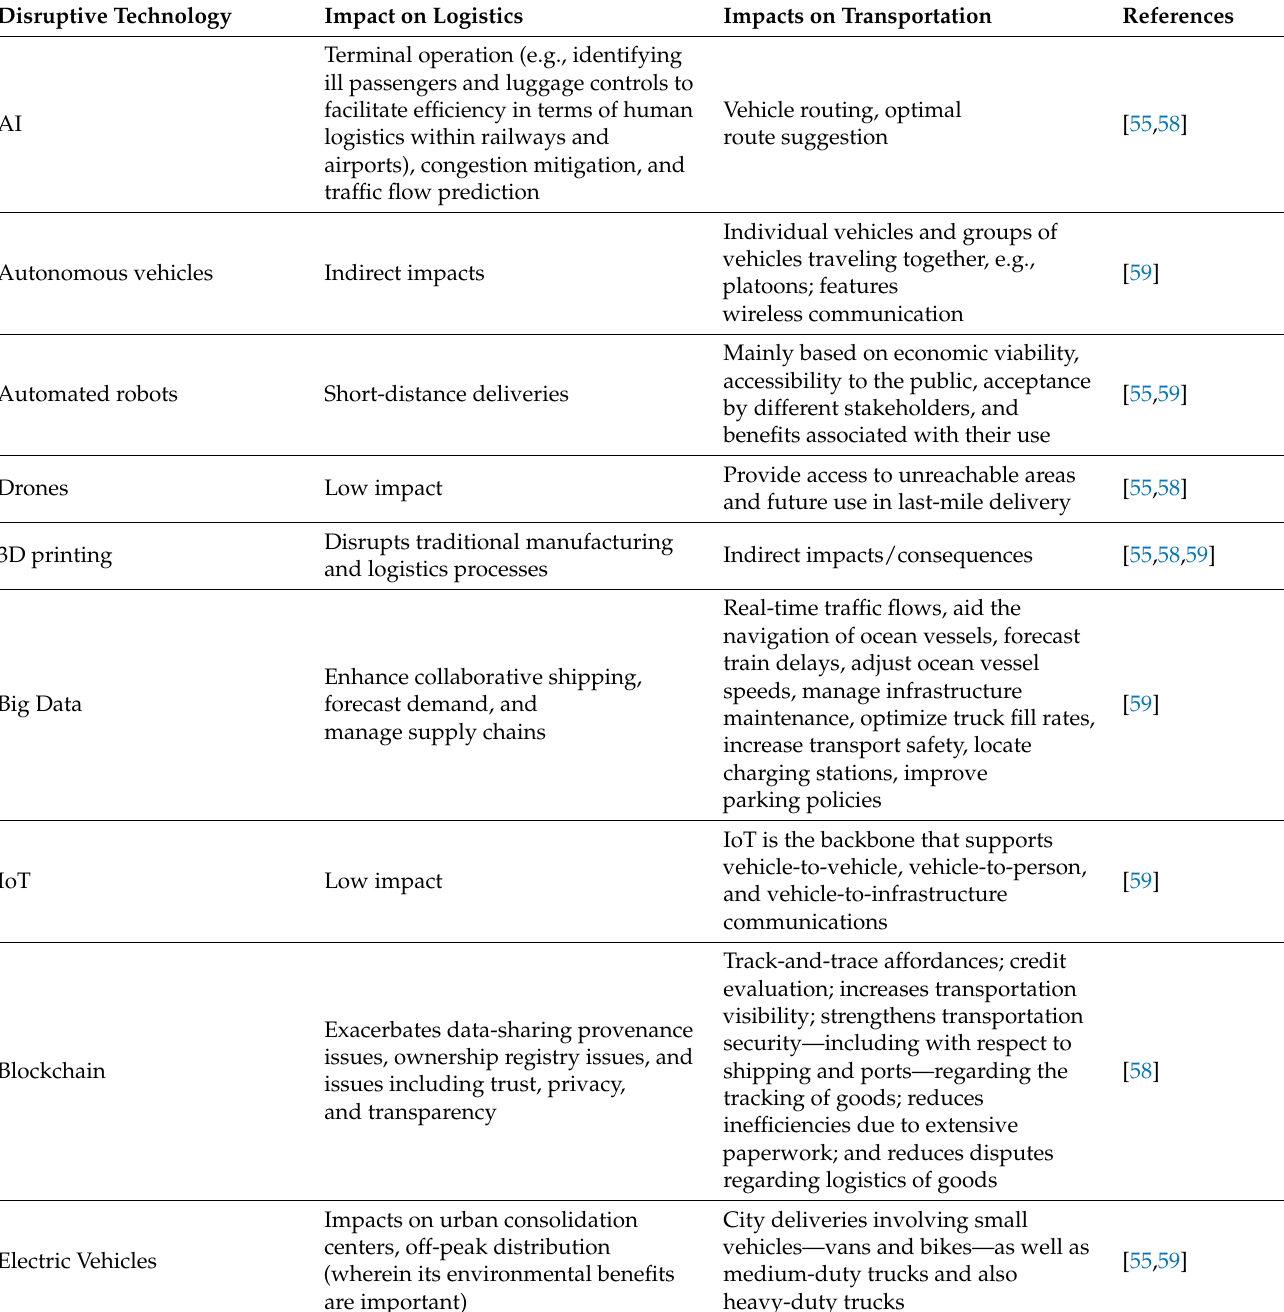
Table 5. Examples of disruptive technologies and their impacts on L and